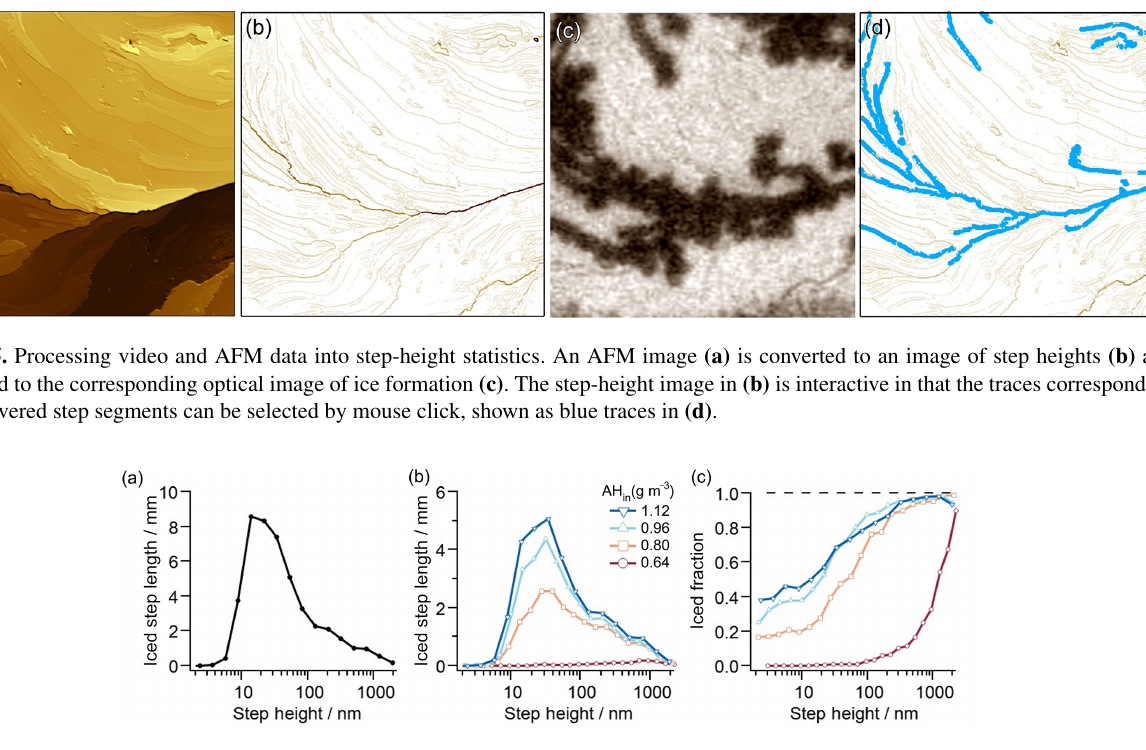
Figure 6. Step-height statistics. (a) Histogram of all step heights as measured by the total length of all steps within a step-height bin. (b) Histogram of step heights as measured by the total length of iced steps within a step-height bin. The histograms evaluate 15 images, each image covering 100µm × 100µm. The bins are logarithmically spaced, and binning for each step height is counted up as the sum of step-edge lengths. (c) Probability of finding ice on a step of a given height, computed as the total length of iced steps within a step-height bin divided by the total length of all steps (within the same step-height bin). The data show that increasing humidity shifts the distribution to the left, thus increasing the probability of finding ice on smaller step heights. Fluctuations in the ice fraction curves, particularly at high AH in and on large steps, reflect the random dehydration of some larger step heights which are present in far fewer numbers than are smaller step